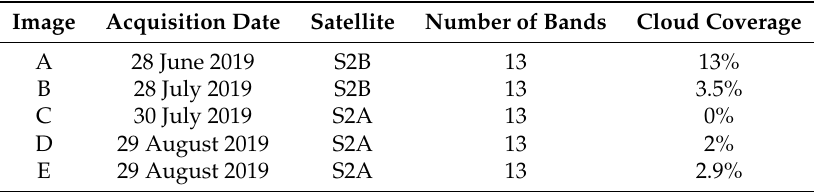
Table 1. Acquisition time of S2A and